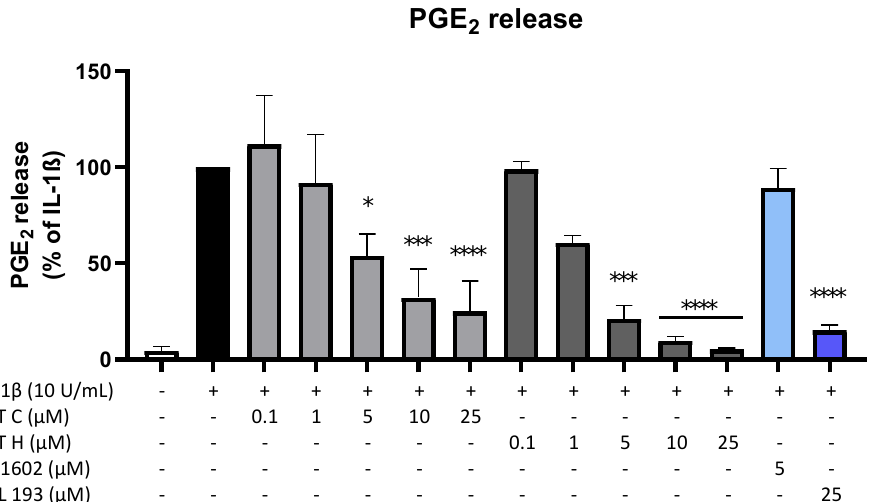
Figure 2. Effects of KIT C (light grey bars), KIT H (dark grey bars), O-1602 (light blue bar), and ML 193 (blue bar) on PGE 2 -release in IL-1 β -stimulated SK-N-SH cells. Cells were stimulated as described under material and methods. After 24 h of stimulation, supernatants were collected and the release of PGE 2 was measured by EIA. Values are presented as the mean ± SEM of at least three independent experiments. Statistical analysis was performed using one-way ANOVA with Dunnett’s post hoc tests with * p < 0.05, *** p < 0.001, **** p < 0.0001 compared to IL-1 β .